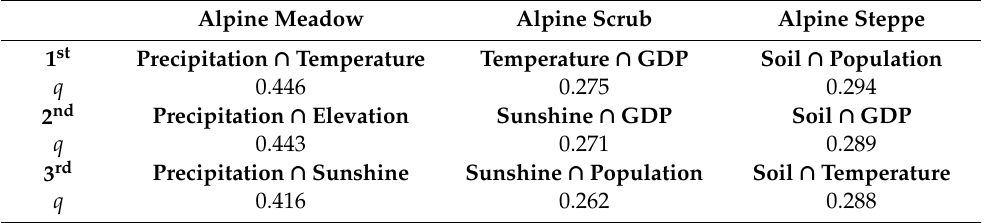
Table 3. The dominant interactions between two impact factors in di ff erent vegetation types. The interactive detector was used to check whether two impact factors work independently or